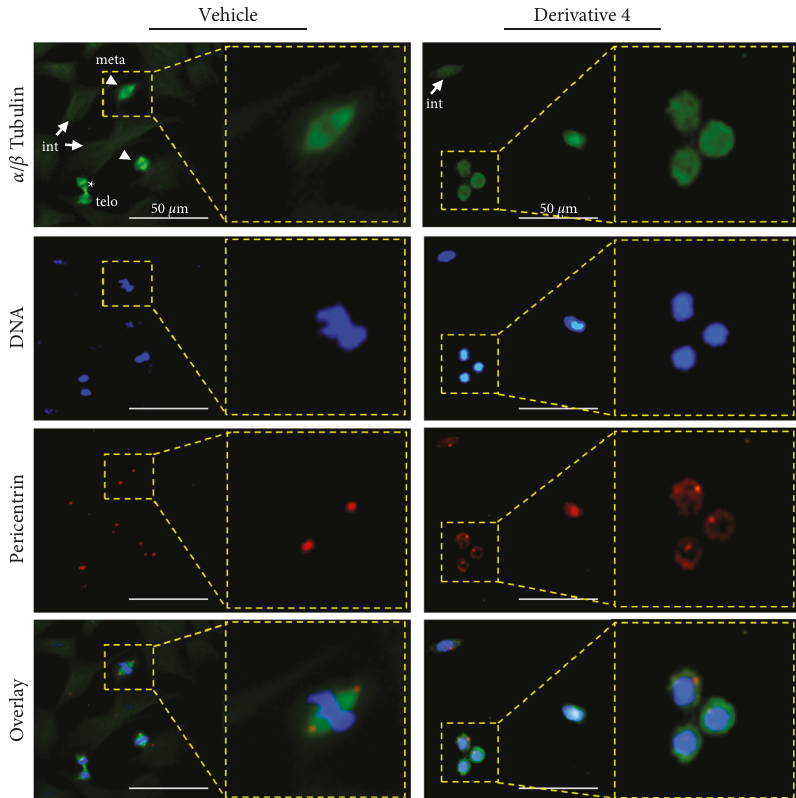
Figure 6: effect of derivative 4 on mitotic spindle formation. HCT116 cells cultured on coverslips were treated with 40 μ M derivative 4 for 24h The cells were fixed and incubated with antibodies against α,β -tubulin and pericentrin for 2 h followed by incubation with an AlexaFluor 488-conjugated (for α , β -tubulin, green signal) and AlexaFluor 555-conjugated (for pericentrin, red spot) secondary antibodies for 30 min. Nuclear DNA was stained with 1 μ g/mL Hoechst 33258 for 10min (blue signal). M phase cells were selected and analyzed for assembly of mitotic spindles. The fluorescent signals were imaged using an EVOSf1 ® fluorescence microscope. Arrows, interphase cells (int); arrowheads, metaphase spindle (meta); star-like, telophase spindle (telo). Scale bars, 50 μ m.